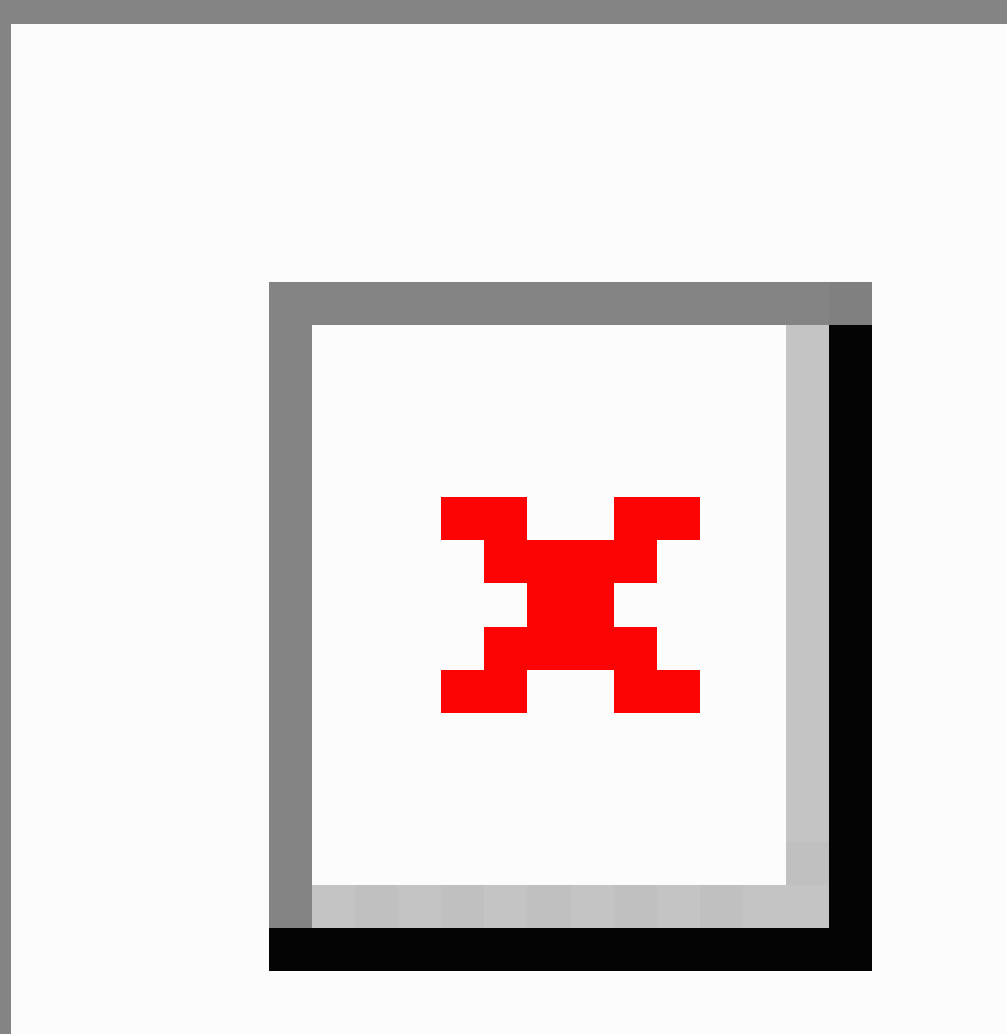
Figure 3. Examples of graphical physical activity and sitting feedback provided by the MOPOrtal service. The line plot represents the weekly feedback (red area—user’s mean average daily moderate to vigorous physical activity (MVPA) is below the global recommendation (60 min/day); yellow and green area—user’s daily moderate to vigorous physical activity level corresponds to the recommendation). The minute accumulations of moderate to vigorous physical activity are given at every 2-hour periods, with the numbers marked as green indicating high accumulation. The thumb gives feedback indicating whether the daily recommendation was fulfilled or